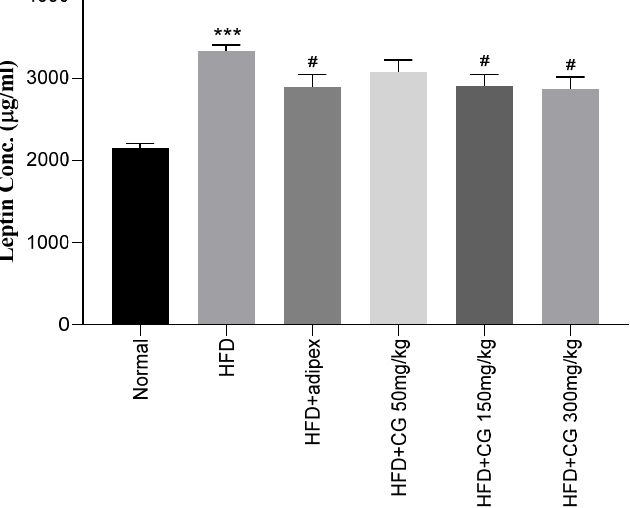
Figure 4. Effect of chitoglucan on serum level of leptin. Data represent means ± S.E.M. * ** p < 0.001 compared to Normal group, # p < 0.05 compared to HFD group. compared to Normal group, # p < 0.05 compared to HFD group.